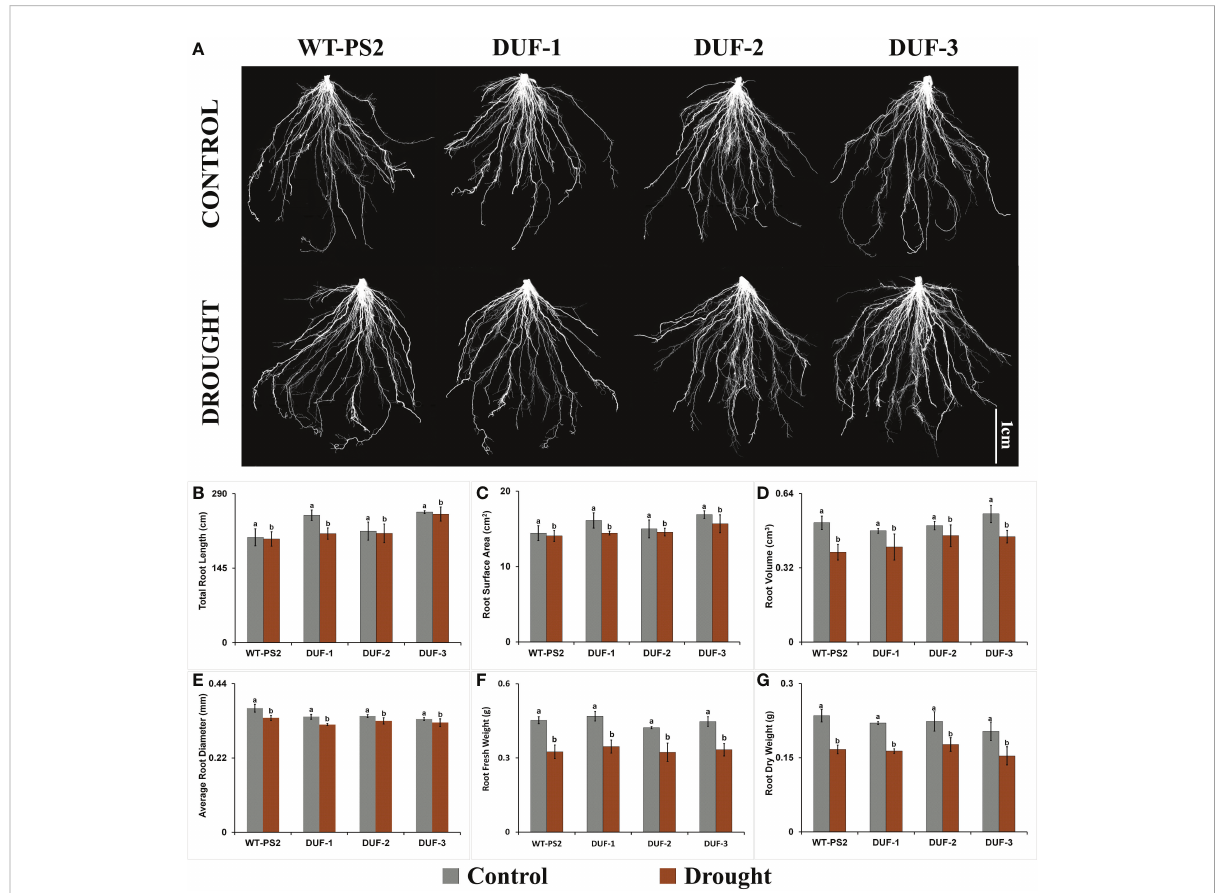
FIGURE 3 Root system architecture of AtRd29A::OsSRDP transgenic lines and WT plants under drought stress. (A) Comparative root architecture system images of WT and three AtRd29A::OsSRDP transgenic lines (DUF-1, DUF-2, and DUF-3) under control and drought stress conditions. All root images were captured using a fl atbed scanner (Epson Perfection V700) with a resolution of 400 dpi on 28-day-old seedlings. (B – G) Comparison of root phenotyping traits between AtRd29A::OsSRDP transgenic rice lines and WT plants under control and drought stress. (B) Total root length, (C) root surface area, (D) root volume, (E) root diameter, (F) root fresh weight, and (G) root dry weight. Each value is the average of three independent biological replicates and the vertical bar indicates ± SD. Standard error of means (SD/ √ N; N = 3) are used as error bars, and alphabets above the vertical bars represent statistically signi fi cant differences (Duncan ’ s Multiple Range Test: p ≤ 0.05) between transgenic rice lines (AtRd29A::OsSRDP) and WT